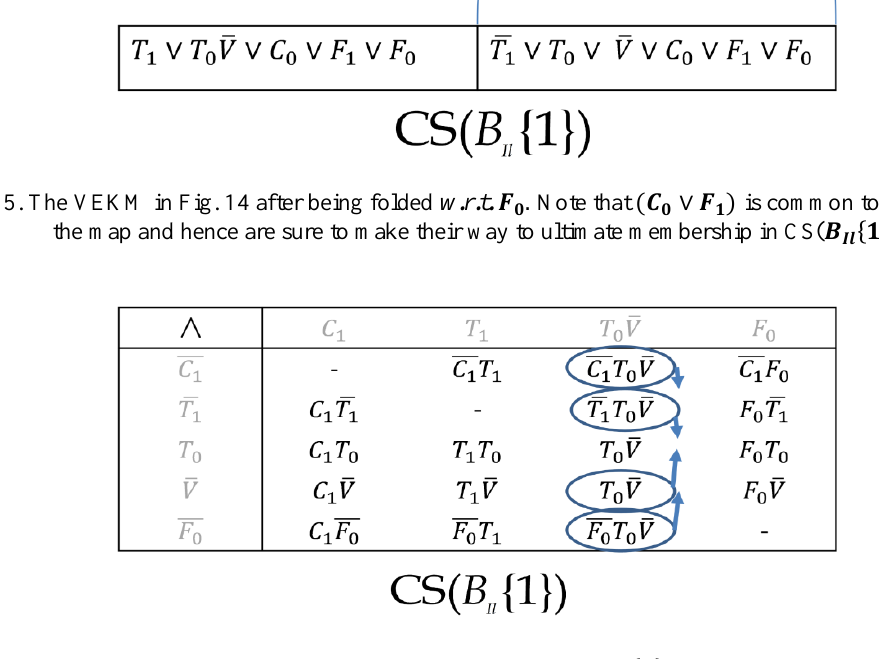
{ } . Note that an encircled term is 𝐥 { }) and are not 𝑰𝒍 shown